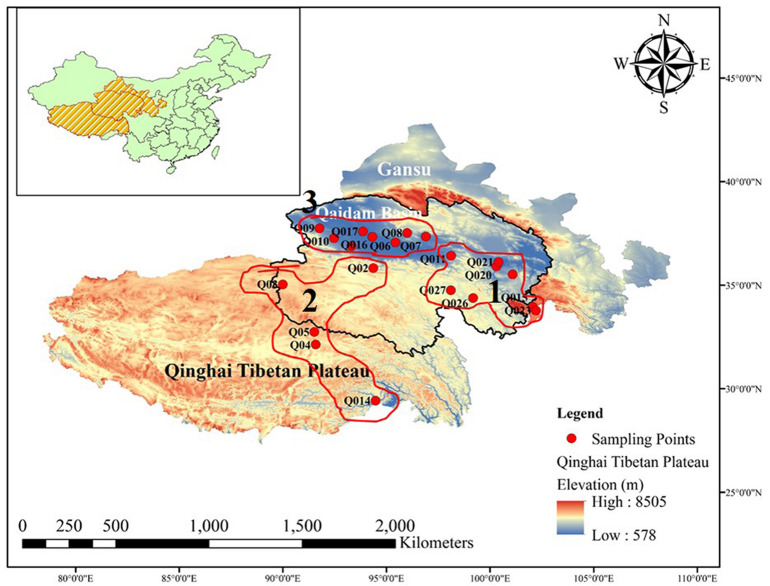
Map of Qinghai Tibetan Plateau, China. Geographical distribution of the 54 sites where bacterial diversity samples and environmental data were collected. All the sampled sites are marked by red circles. The panel insert highlights the location of the Qaidam Basin in the Qinghai Tibetan Plateau of China.